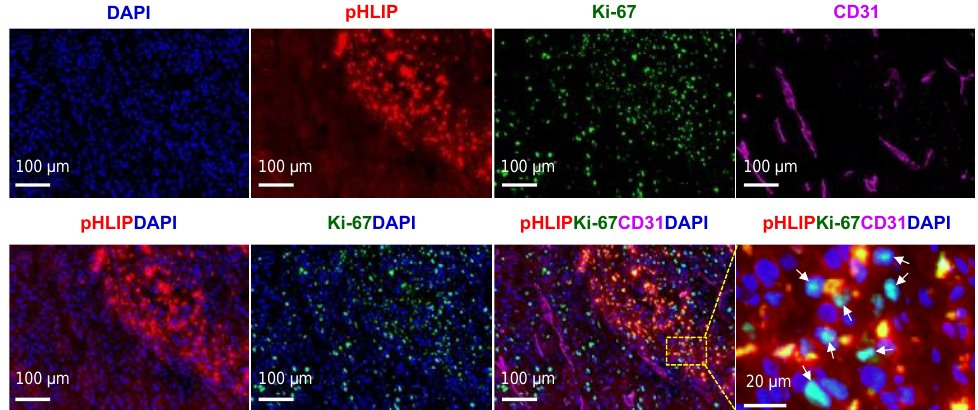
Figure 8. Tumor proliferation status in the pHLIP-accumulated region. pHLIP (AF546-pHLIP) distribution and proliferation status were examined at the same sites of the same tumor sections. Shown here is a representative high pHLIP-accumulated region (red) with double immunofluorescence staining for the proliferation marker Ki-67 (green) and microvessels (CD31, magenta) in a U87MG tumor section. Blue indicates nuclei stained with DAPI. An enlarged view of the dotted rectangle clearly shows the Ki-67-positive stained cells (arrowheads, aqua).